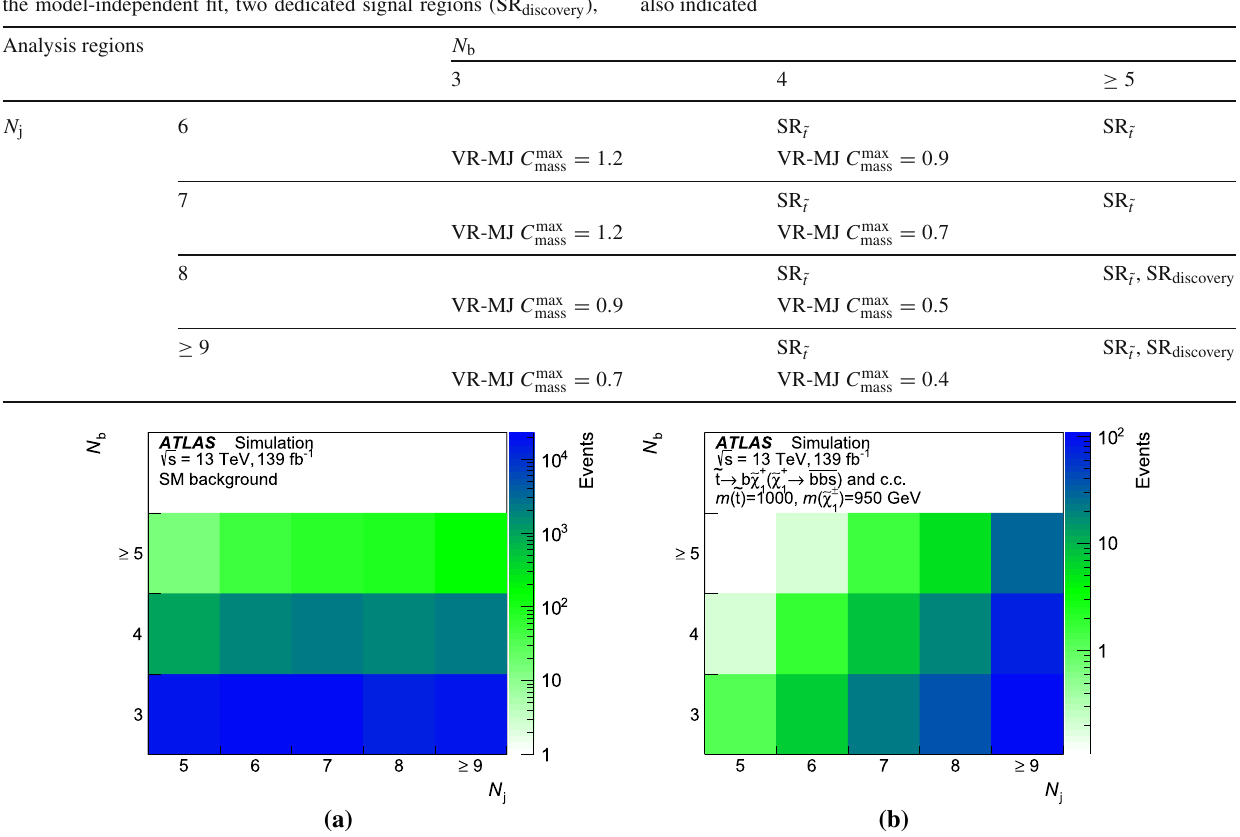
Fig. 2 Predicted numbers of events as a function of jet multiplicity, N j , and b -tagged jet multiplicity, N b , for a SM background (multijet and top-quark production) and b top-squark pair production in the ˜ t → ¯ b ˜ χ +